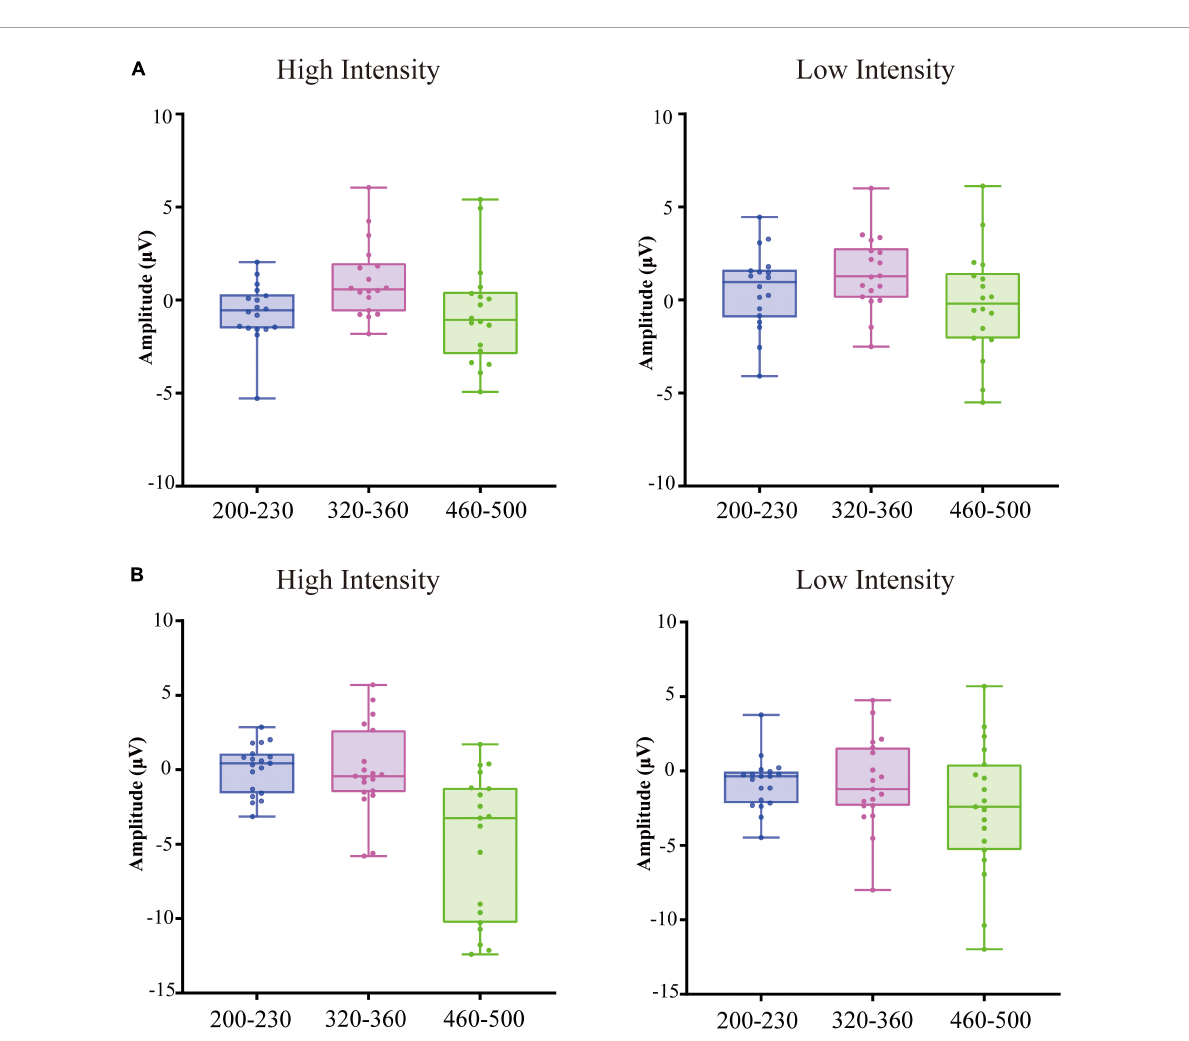
FIGURE2 Box plots of the amplitude averaged over frontal, fronto-central, central, centro-parietal, Occipital regions at 200–230 ms relative to auditory onset, 320–360 ms relative to auditory onset, 460–500 ms relative to auditory onset in older adults (A) and younger adults (B) .